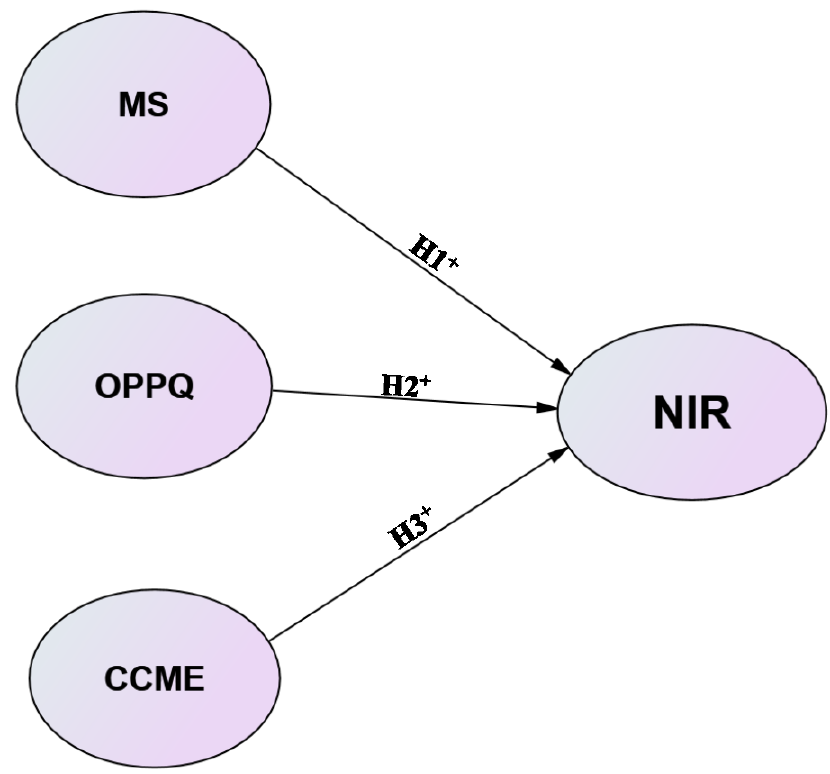
Figure 1. Research